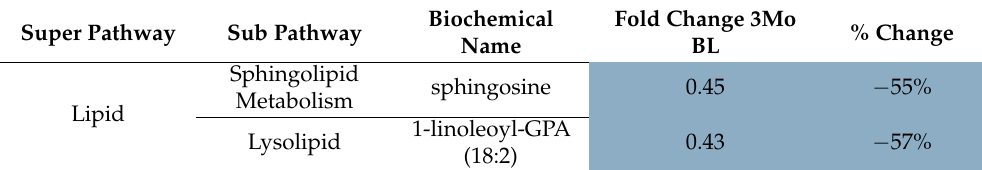
Table 9. Metabolites associated with Neuropathic